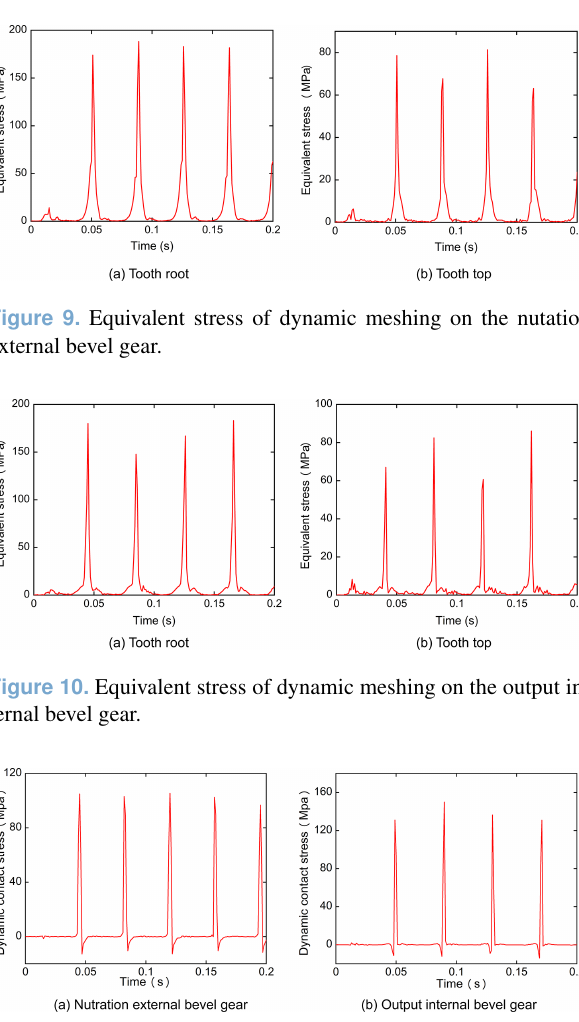
Figure 11. Dynamic contact stress on the double circular spiral bevel